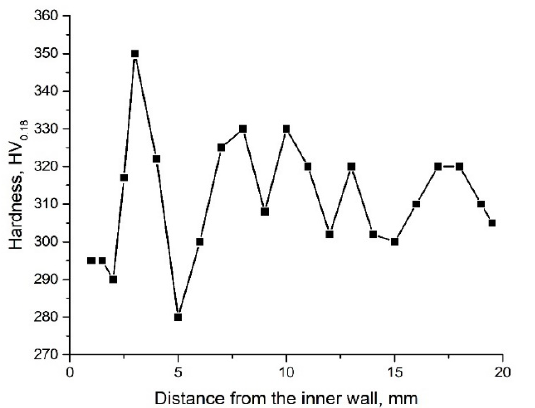
Figure 13. Distribution of microhardness on cross-section of the wall of casing tube (CT).